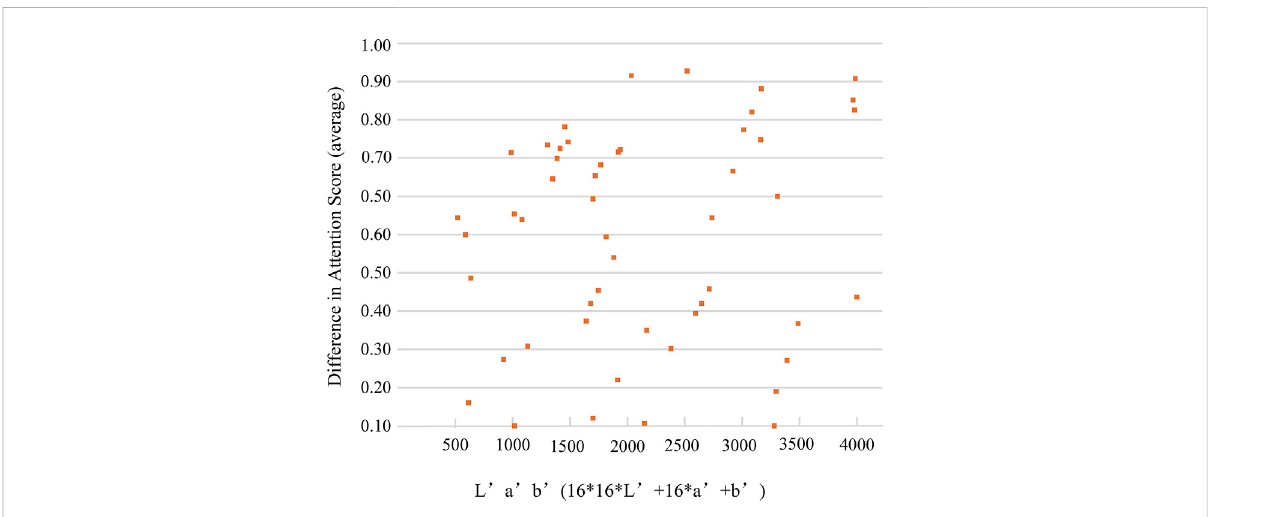
FIGURE 3 Statistics on the colors that affect attention. Coded colors and the DAS. In CIELab color space, we let L ’ = 2.55 *L, a ’ = a +127, b ’ = b + 127, and code L ’ a ’ b ’ = 16 * 16 *L ’ +16 * a ’ + b ’ .